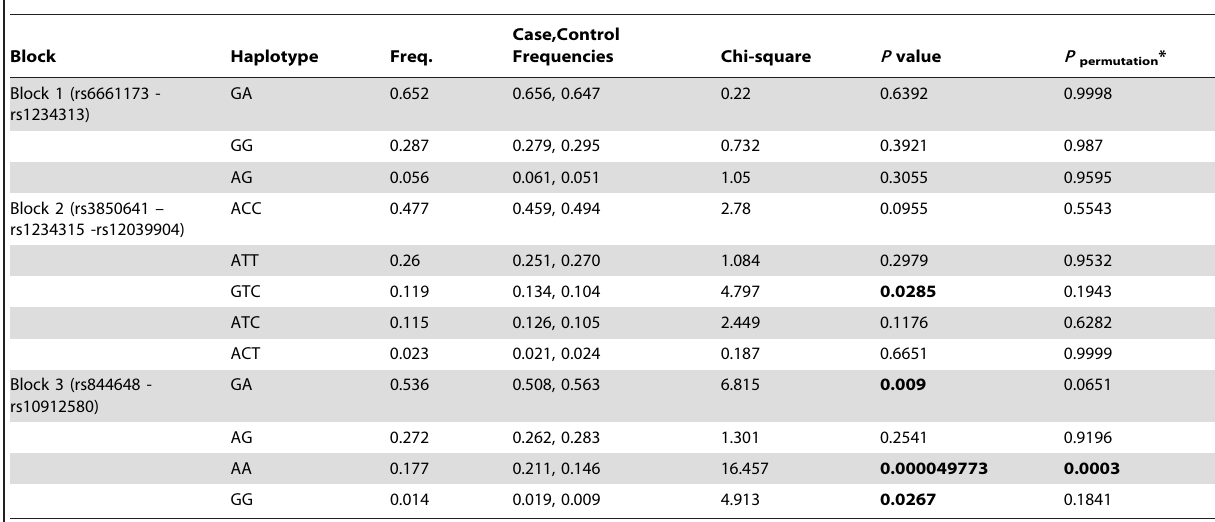
Table 4. Haplotype of OX40L gene SNPs in cases and controls.